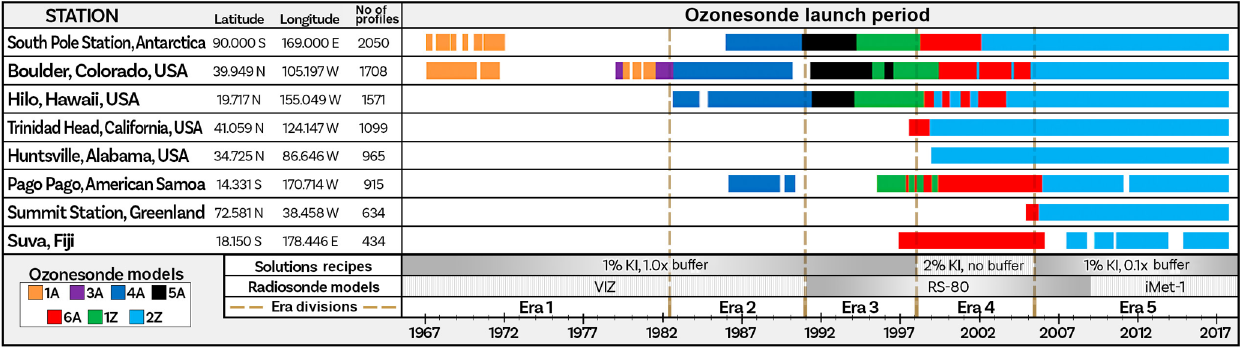
Figure 1. The eight long-term NOAA ozonesonde stations with latitude, longitude, number of profiles, and launch